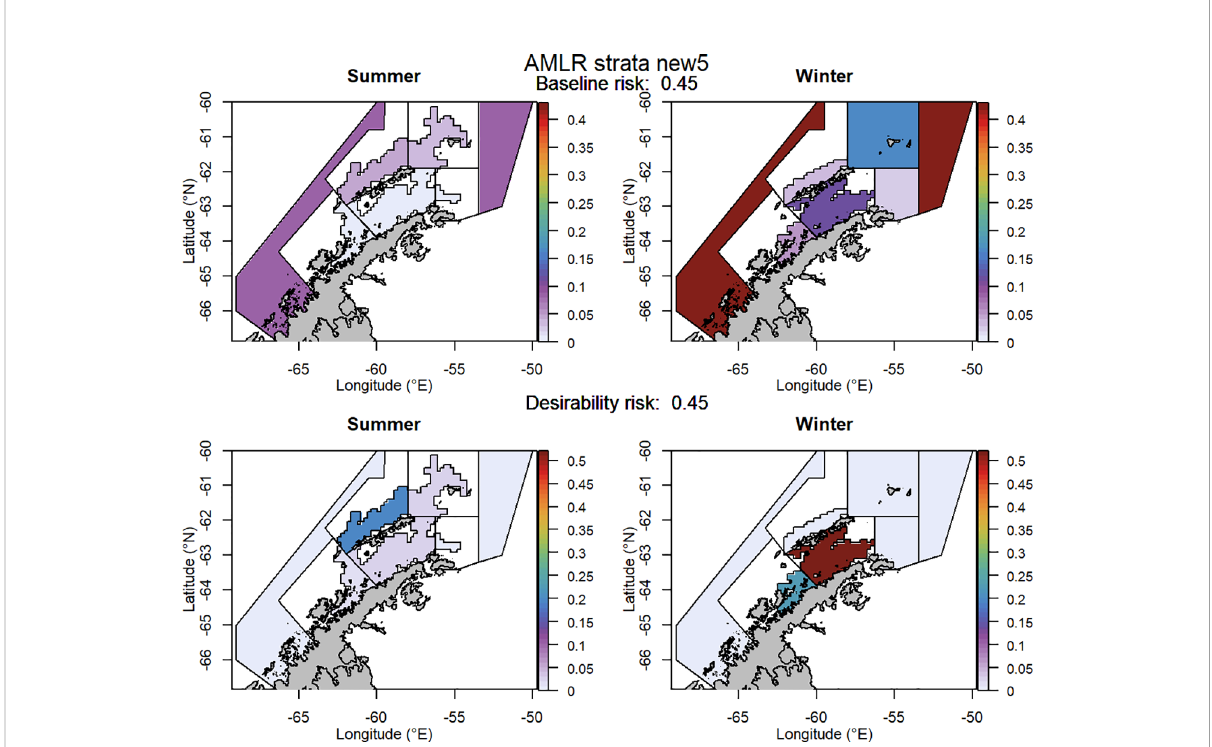
FIGURE 8 The proportion of the annual krill catch limit that could be taken from each management unit (delineated using the US-AMLR survey strata with an added management unit) during summer and winter when the risk assessment was implemented after the winter krill layer was adjusted and assuming catch is not evenly distributed within management units. Values sum to 1 across all management units and for both seasons for each of the baseline (upper panel) and desirability (lower panel)